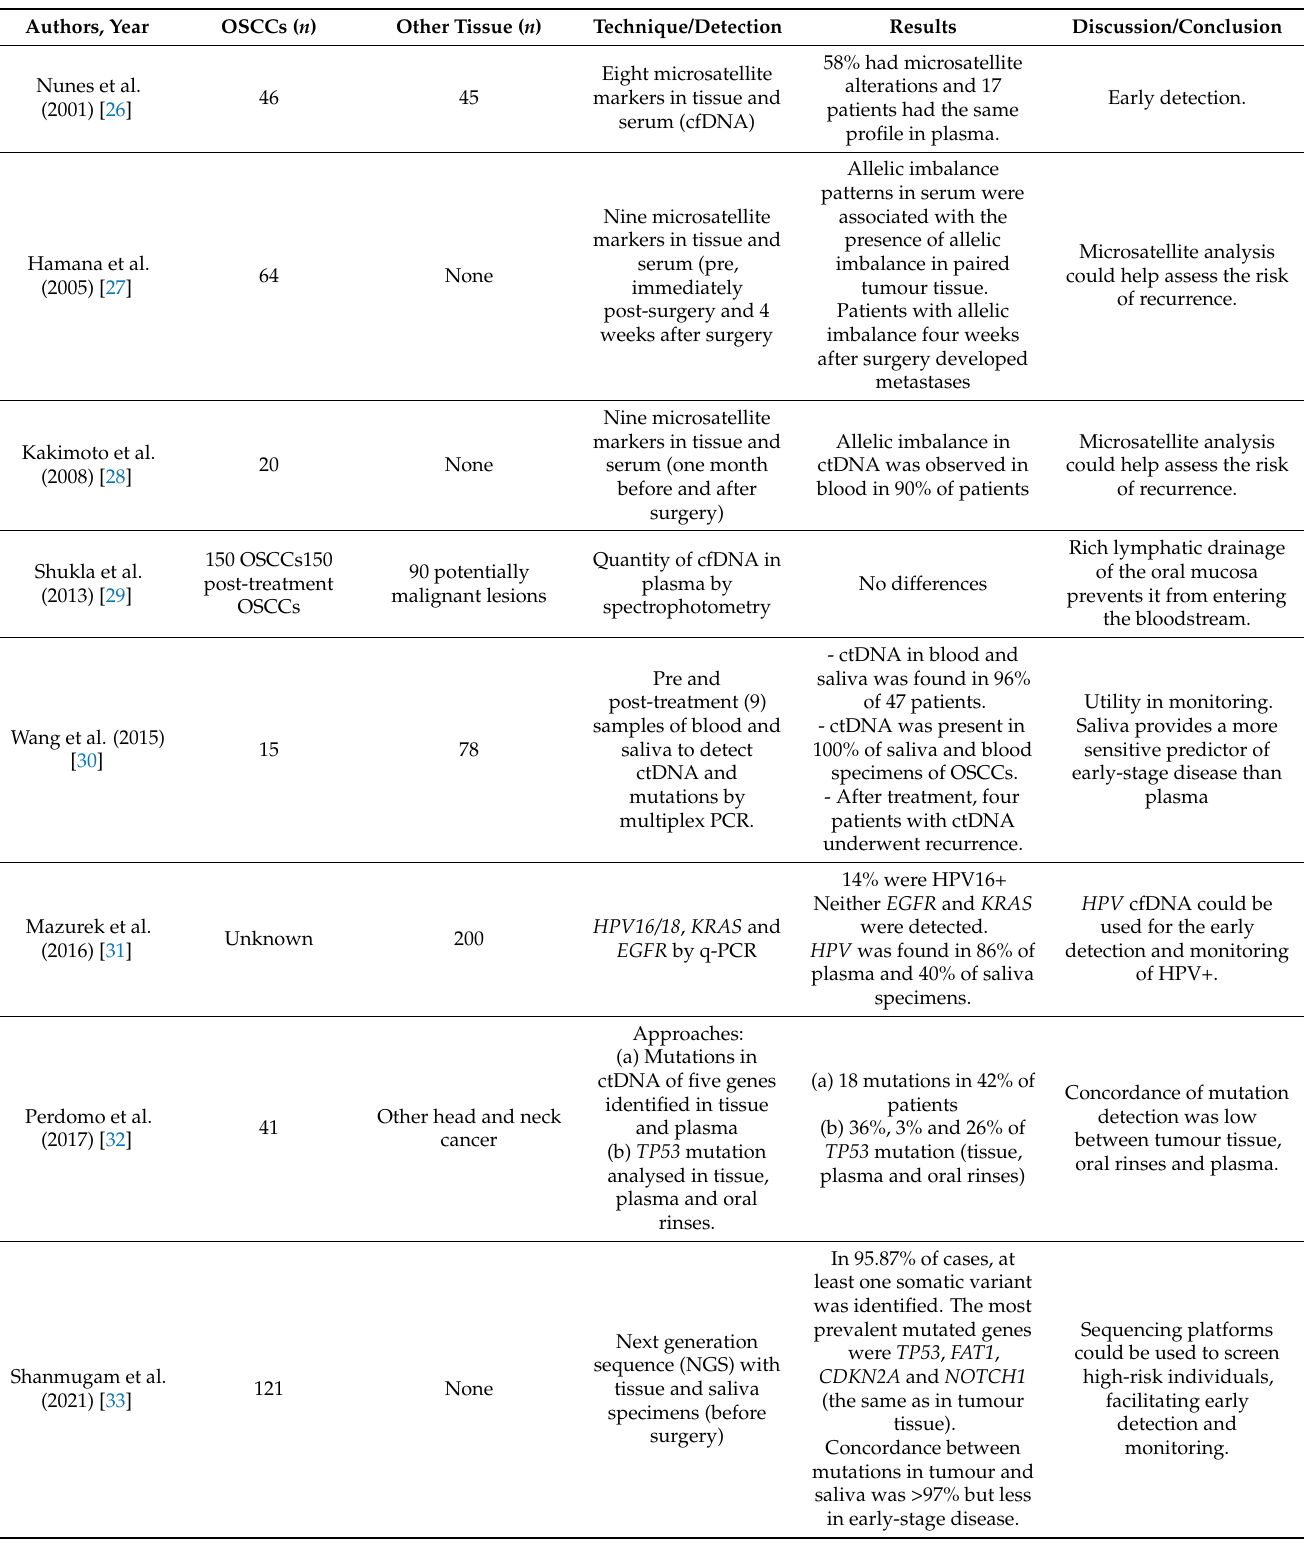
Table 1. Studies of cell free DNA (cfDNA)/circulating tumour DNA (ctDNA) in blood and/or saliva samples from oral squamous cell carcinomas